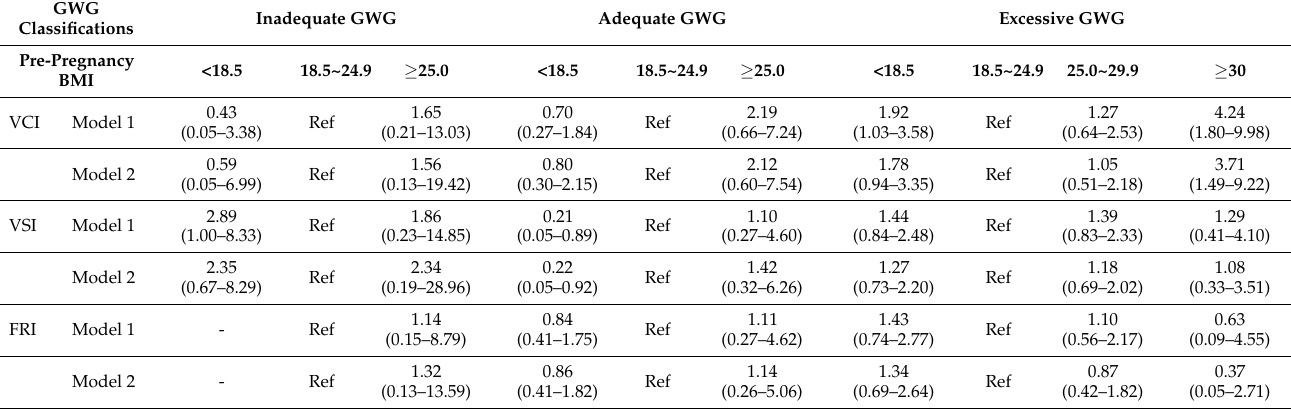
Table 4. Poisson’s regression analysis of the association between different maternal pre-pregnancy BMI and dimensions of children’s cognition under different GWG classifications [ OR ( 95%CI